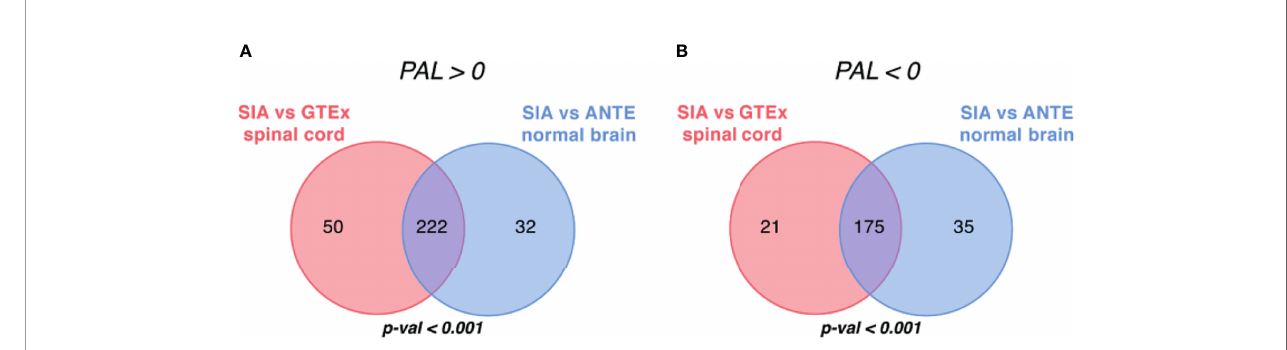
FIGURE 5 | Intersection of differentially regulated molecular pathways between spinal intramedullary astrocytomas (SIAs), GTEx healthy spinal cord, and ANTE healthy brain samples. Intersections of signi fi cantly (A) upregulated (PAL >0) and (B) downregulated (PAL <0) molecular pathways between SIA – GTEx spinal cord and SIA – ANTE normal brain samples are shown; p -values for intersection signi fi cance obtained in perturbation test are highlighted in